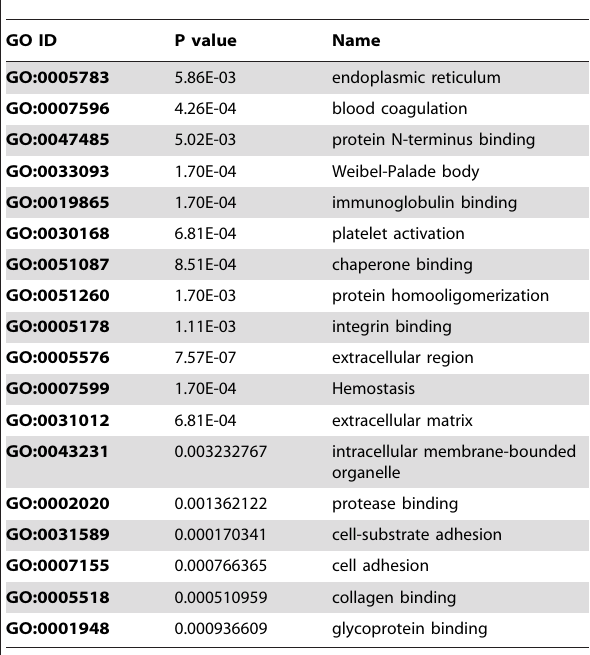
Table 2. Significant functions (P value , 0.01) of the progression-related sub network deregulated initially from